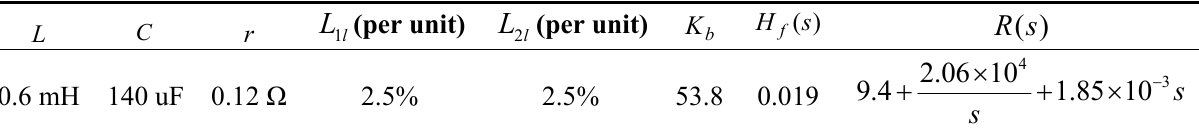
Table 1. Parameters of Inverter and Controller.